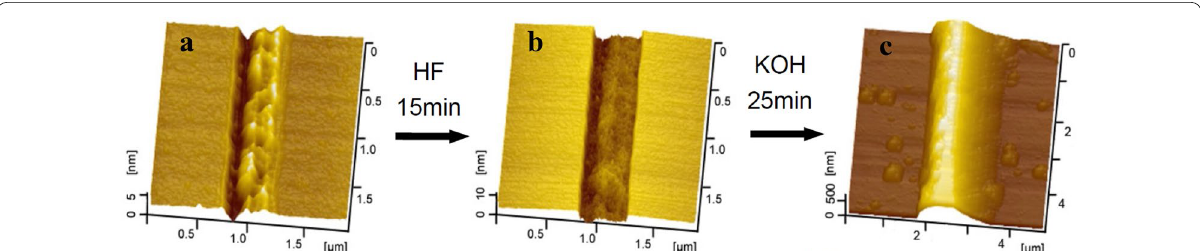
Figure 13 Anti-etching behavior of the distorted silicon layer on groove structure [27]: ( a ) A groove produced by scratching on Si(100) surface. ( b ) AFM image of the scratch after being etched in 10 wt.% HF solution for 15 min to remove surface oxidation layer. ( c ) AFM image of the scratch after being etched in 20 wt.% KOH IPA solution for 25 min +